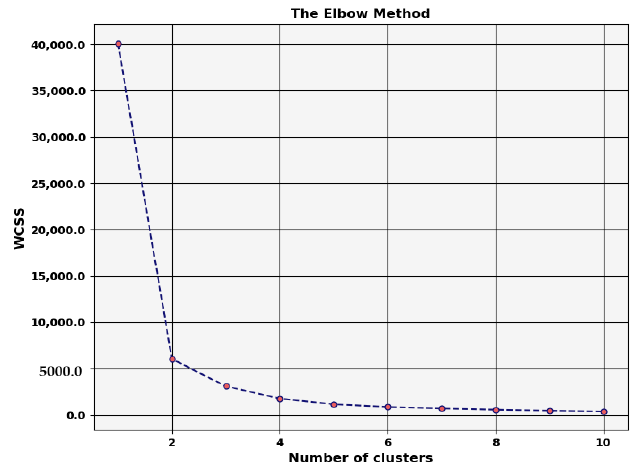
Figure 6. Graph of elbow method to show error for optimal clustering.